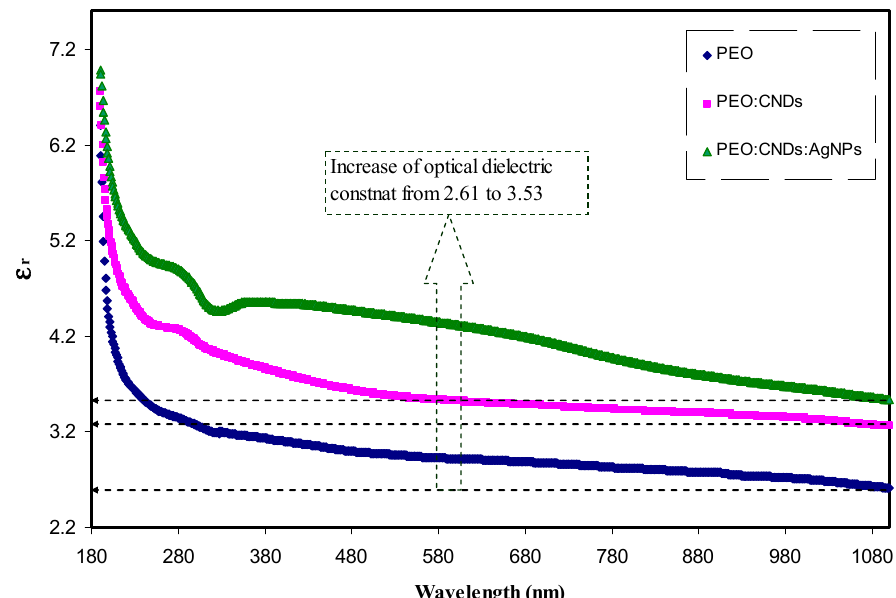
Figure 14. Optical dielectric constant spectra of pure PEO (PEPN0), PEO:CNDs (PEPN1), and PEO:CNDs:Ag (PEPN2) composite samples.